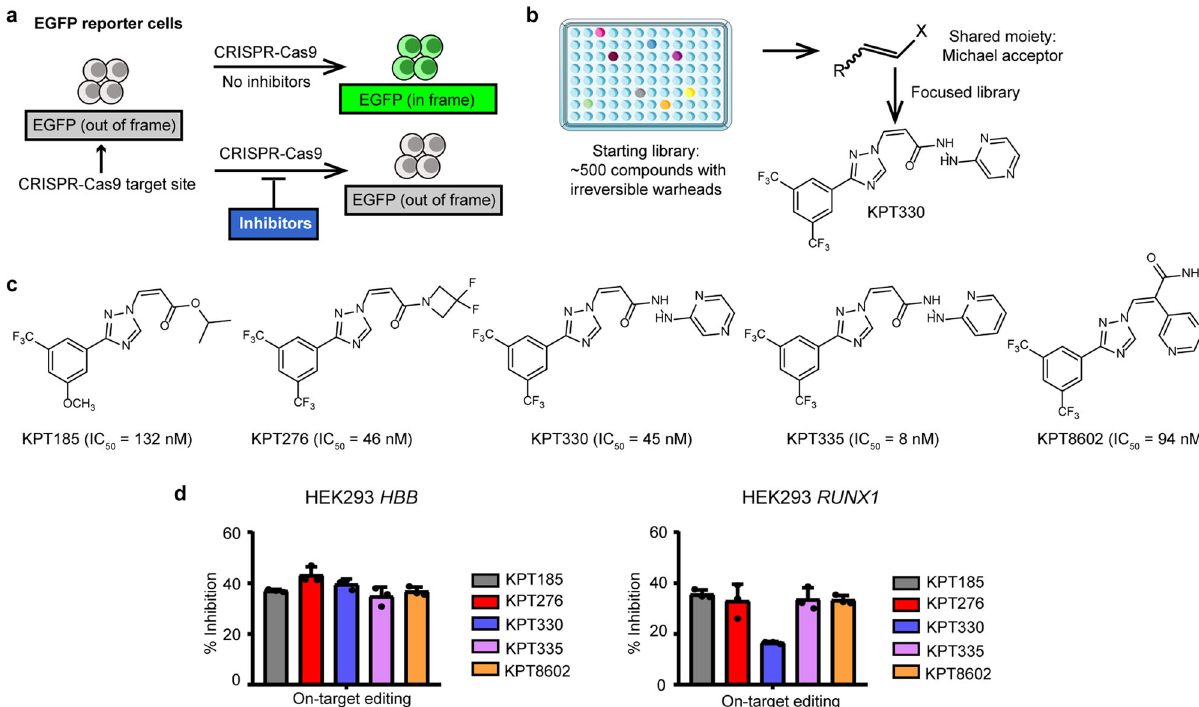
Fig. 1 Identi fi cation of SINEs as CRISPR-Cas9 inhibitors. a Schematic presentation of EGFP reporter cell-based screening of CRISPR-Cas9 inhibitors. b Flowchart of the screening process. X, electron withdrawing group. c Potency of SINEs on inhibiting CRISPR-activated EGFP fl uorescence. d SINEs at 0.5 μ M inhibit the on-target editing activity of CRISPR-Cas9 at HBB and RUNX1 genes in HEK293 cells. The data are shown as mean ± SD ( n = 3 biologically independent